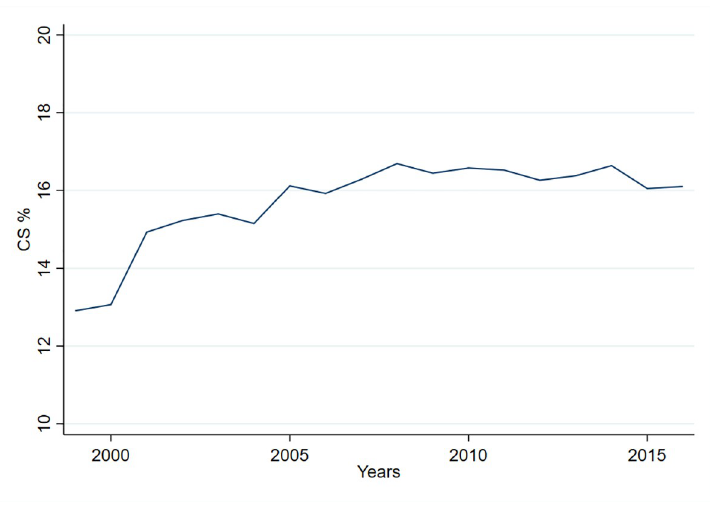
Fig 2. Proportions of CS in all births expressed as % per year, 1999–2016. The total proportion of births in Norway delivered by CS during the study period. CS AU : AbbreviationlistshavebeenaddedforthoseusedinFigs 2 (cid:0) 6 : Pleaseverifythatallentriesarecorrect : , cesarean section.